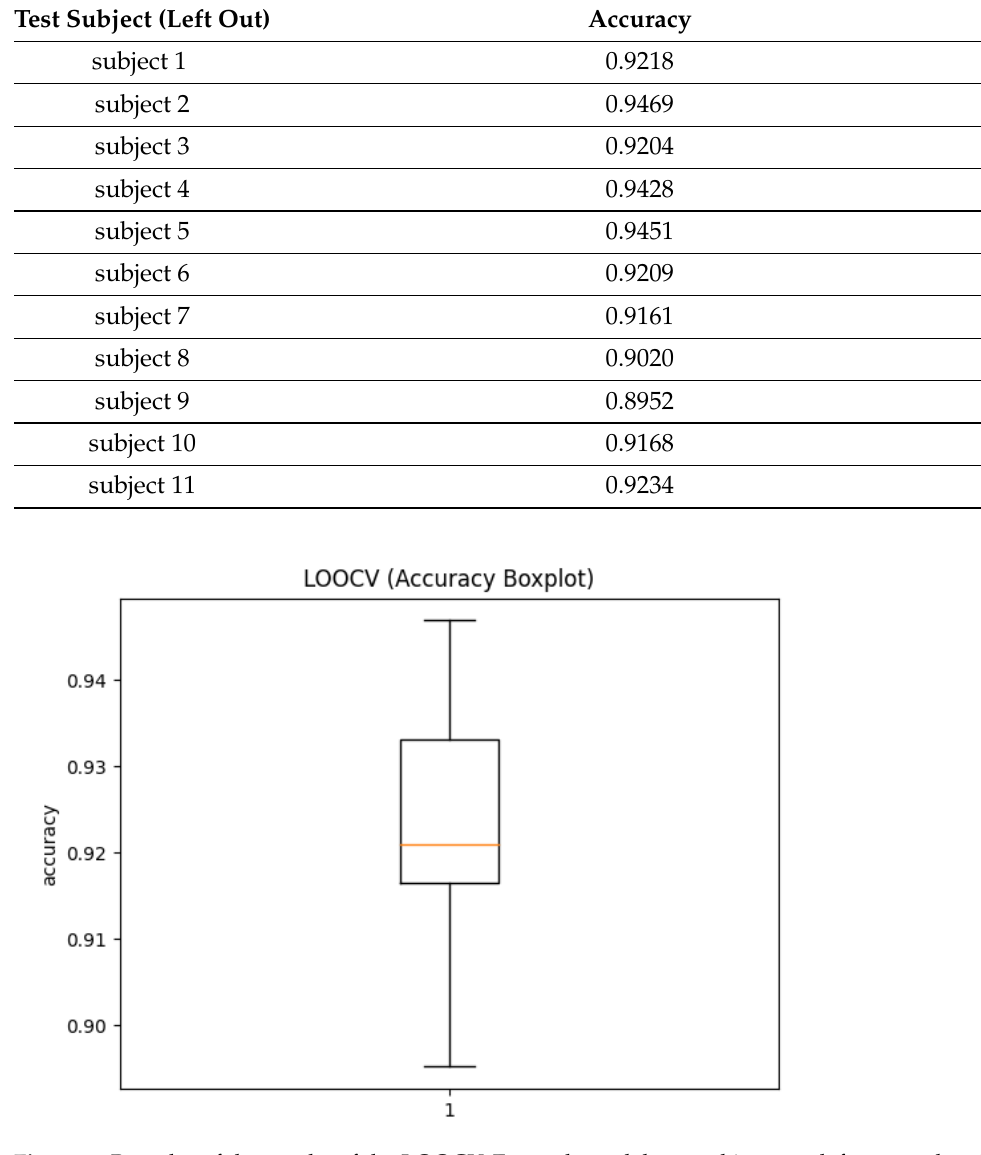
Figure 5. Box plot of the results of the LOOCV. For each model one subject was left out, and each model was tested for said subject. The median accuracy was